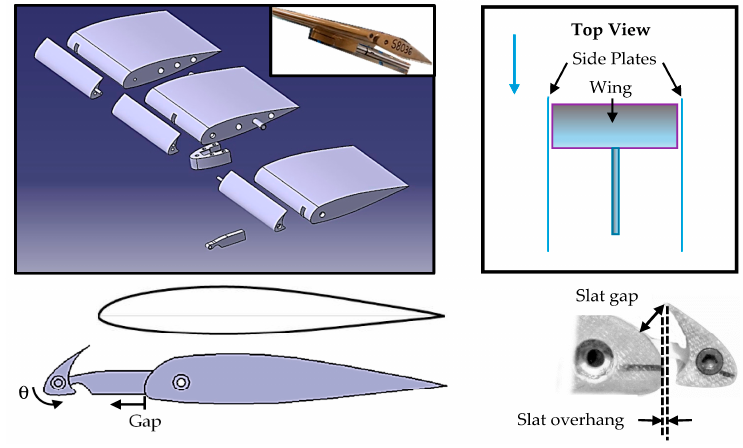
Figure 1. Rendering showing wind tunnel model construction, model sting installation (inset), side plate installation, airfoil profile and slat variable definitions.